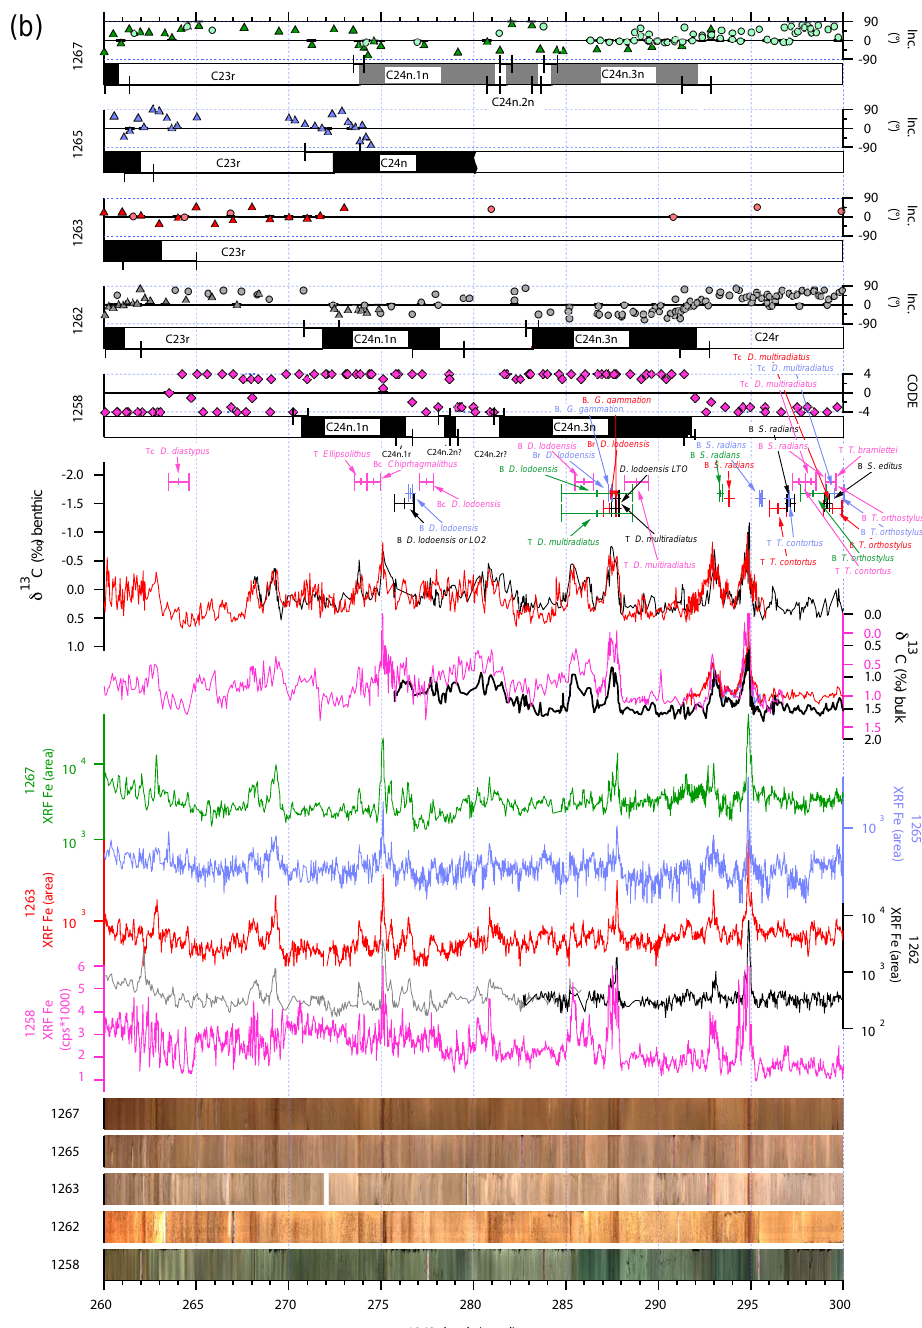
Figure 2. (a) Overview of bio- and magnetostratigraphic data, XRF core scanning Fe intensity data, and core images from ODP Sites 1258, 1262, 1263, 1265, and 1267 from 195 to 270rmcd of Site 1263. The upper five panels show the inclination from characteristic remanent magnetization investigations from this and previous studies with uncertain polarity interpretation in gray. The position of calcareous nannofossil events, including the depth error, is plotted for all sites followed by the compiled benthic and bulk δ 13 C data and XRF core scanning Fe intensities. For a detailed source of data, see the text. Purple: Site 1258; black and grey: Site 1262; red: Site 1263; blue: Site 1265; green: Site 1267. (b) Overview of bio- and magnetostratigraphic data, XRF core scanning Fe intensity data, and core images from ODP Sites 1258, 1262, 1263, 1265, and 1267 from 260 to 300rmcd of Site 1263. See panel (a) . Note that the overview from 300 to 340rmcd of Site 1263 is in Fig. S7 of the